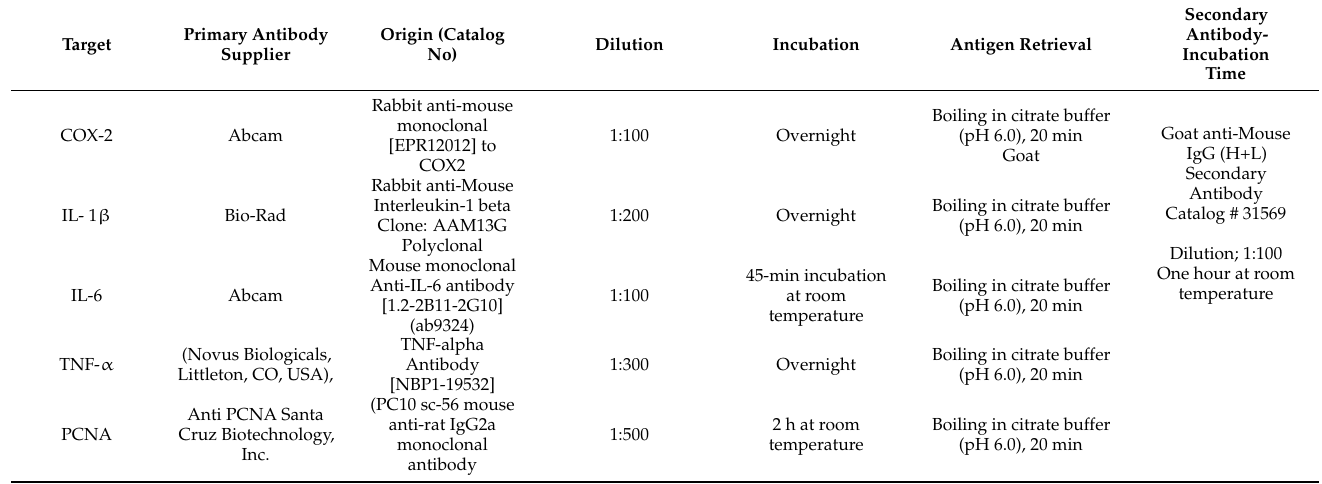
Table 3. Identity, sources, and the working dilution of antibodies used in immunohistochemical